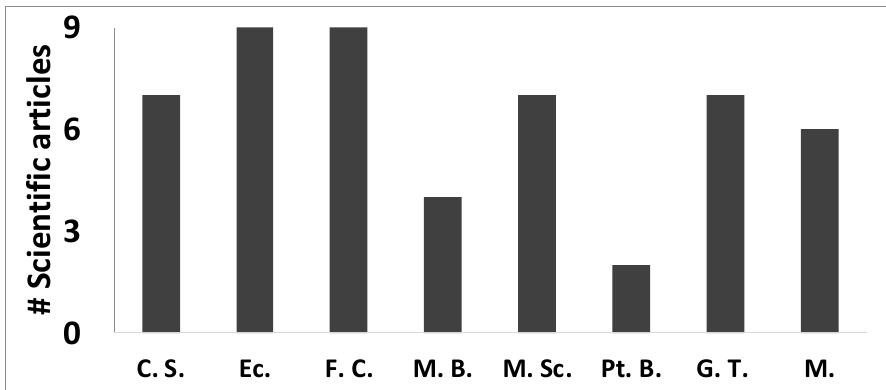
Figure 1. Different studies on Vaccinium floribundum published around the world on topics such as cultivation strategies ( C.S. ), ecology ( Ec ), food chemistry ( F.C. ), molecular biology ( M.B. ), medicinal properties ( M.Sc. ), berry pretreatment ( Pt. B. ), green technology ( G.T. ), and manufacturing ( M